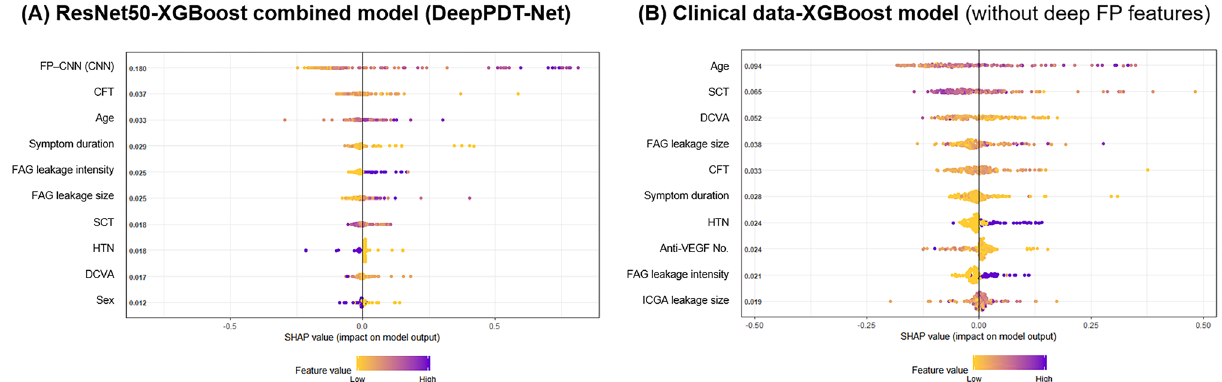
Figure 3. Feature importance summary plots and corresponding SHapley Additive ex-Planations (SHAP) values of ( A ) DeepPDT-Net combining ResNet50 deep features of fundus photographs (FPs) with other clinical data with XGBoost and ( B ) XGBoost model trained exclusively on clinical data without deep FP